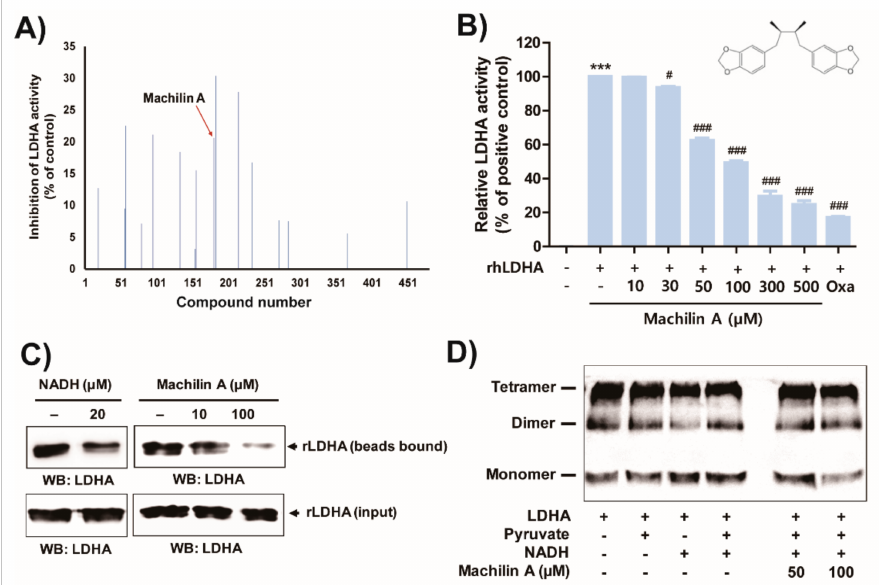
Figure 1. Inhibitory e ff ect of machilin A on Lactate dehydrogenase A (LDHA) activity by binding of the 1,4-dihydronicotinamide adenine dinucleotide (NADH) to LDHA. ( A ) The screening on inhibition of LDH activity was analyzed using purified recombinant LDHA. ( B ) The inhibition of LDH activity was analyzed in presence of the indicated concentrations of machilin A. Oxamate (50 mM) was used as positive control for LDHA inhibition. Results of three independent replicates are presented as means ± SD. Statistic tests were performed using a one-way analysis of variance (ANOVA). *** p < 0.001 compared to the negative control (first column). # p < 0.05 and ### p < 0.001 compared to the positive control (second column). ( C ) The NADH binding ability of LDHA was determined by measuring the a ffi nity of LDHA to agarose-immobilized Cibacron Blue 3GA, an NADH mimic. The purified recombinant human dehydrogenase A (rhLDHA; 400 ng) were incubated with Cibacron Blue agarose in the absence or presence of machilin A (10 and 100 µ M). NADH was used for the positive control. LDHA that bound to beads was subjected to sodium dodecyl sulphate-polyacrylamide gel electrophoresis (SDS-PAGE) and western blotting. Equal amounts of protein were used in each reaction. ( D ) The purified recombinant LDHA (100 ng) with or without machilin A was incubated at room temperature for 5 min in the presence of 0.0025% glutaraldehyde containing 5% glycerol, 10 mM Tris–HCl (pH 7.5), 50 mM NaCl, 0.1 mM ethylenediaminetetraacetic acid (EDTA), and 1 mM dithiothreitol (DTT). The samples were subjected to